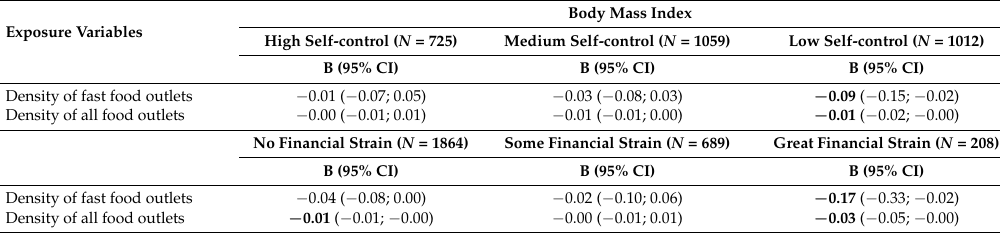
Table 3. Associations between measures of the food environment in a 400m buffer and body mass index stratified by financial strain and